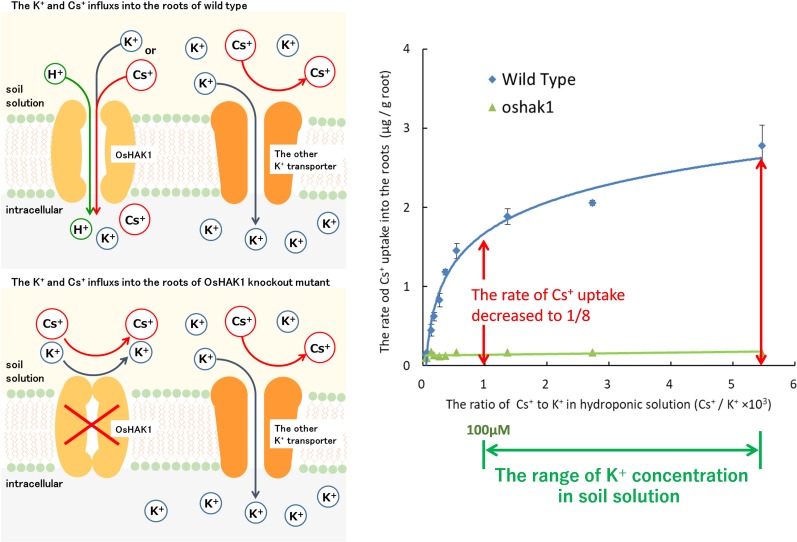
The newly elucidated mechanism of Cs uptake in the rice plants. Upper left side: The root cells of rice (wild type) absorb K+ and Cs+ through OsHAK1 at extracellular K+ concentration below 100 μM. Lower left side: OsHAK1 knockout mutants could not absorb K+ and Cs+ through OsHAK1. However, the rate of K+ uptake was maintained and the uptake was complemented by K+ transporters other than OsHAK1. Possibly, other K+ transporters other than OsHAK1 in the membrane did not permeate Cs+. Right figure: In typical soils, the concentration of K+/the concentration of Cs+ in soil solution is higher than 103. When the K+ concentration in the hydroponic solution is 0–100 μM and the Cs+ concentration is fixed at 75 nM, the rate of Cs+ uptake into the root of the OsHAK1 mutant is reduced to 1/8 or less compared to the wild type. In addition, the rate of the slight Cs uptake is constant regardless of the K+ concentration of the hydroponic solution.